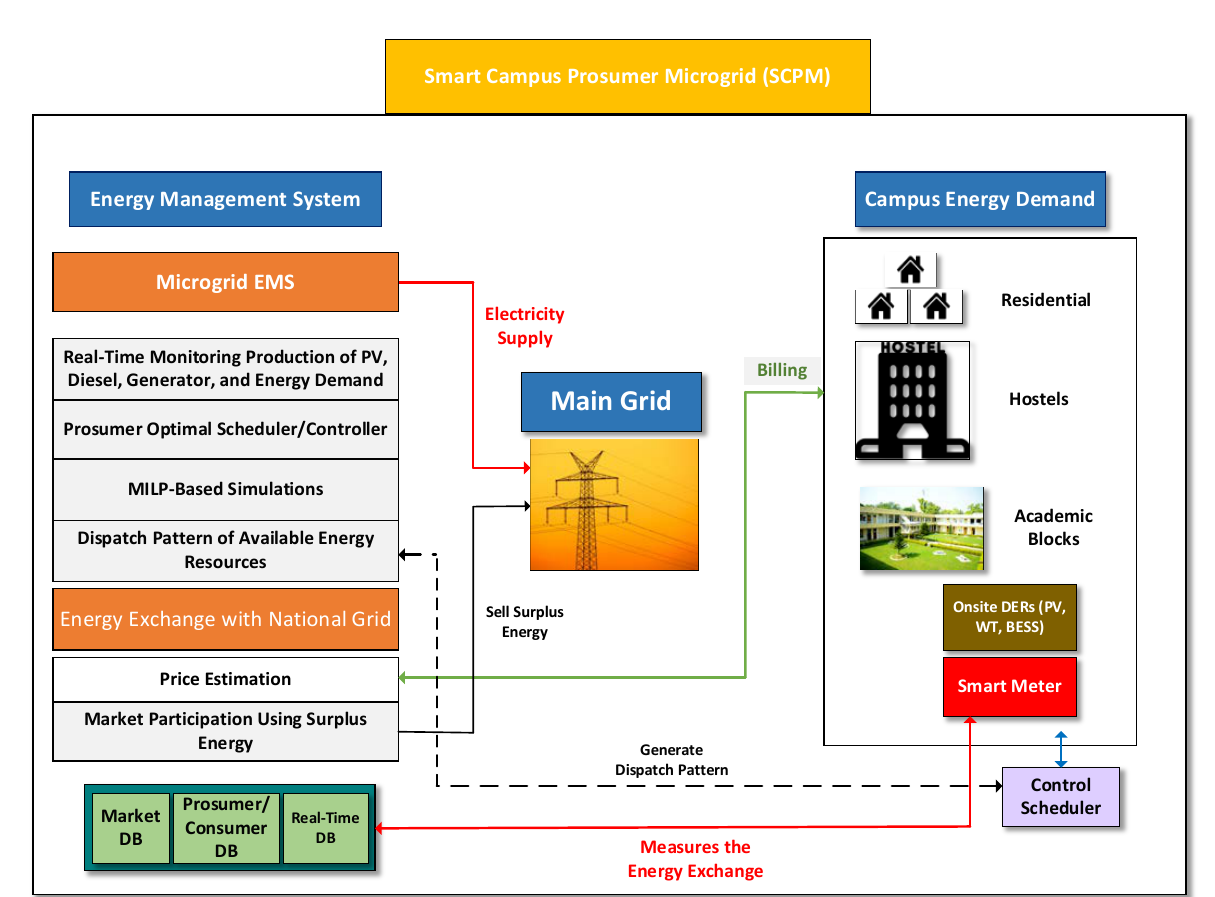
Figure 1. Proposed EMS structure.